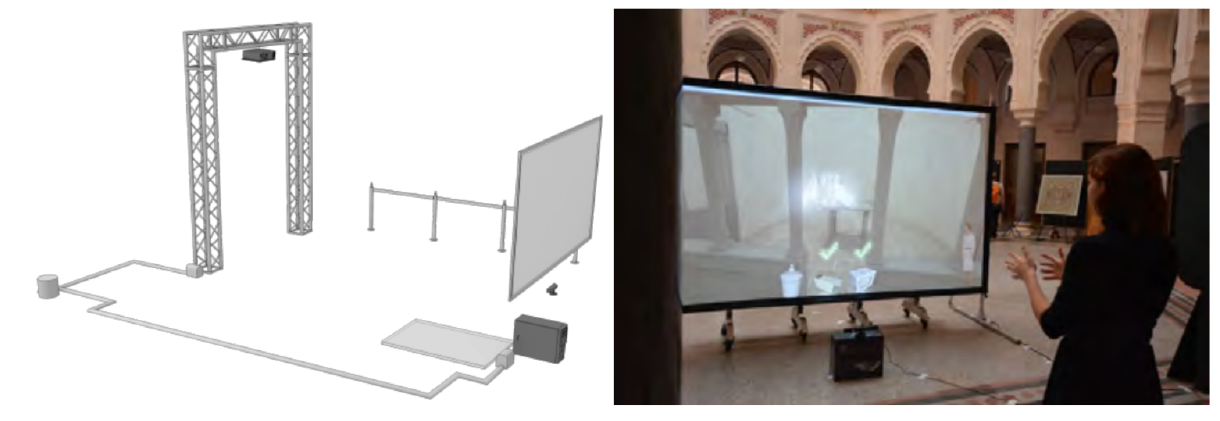
Figure 1. Admotum setup